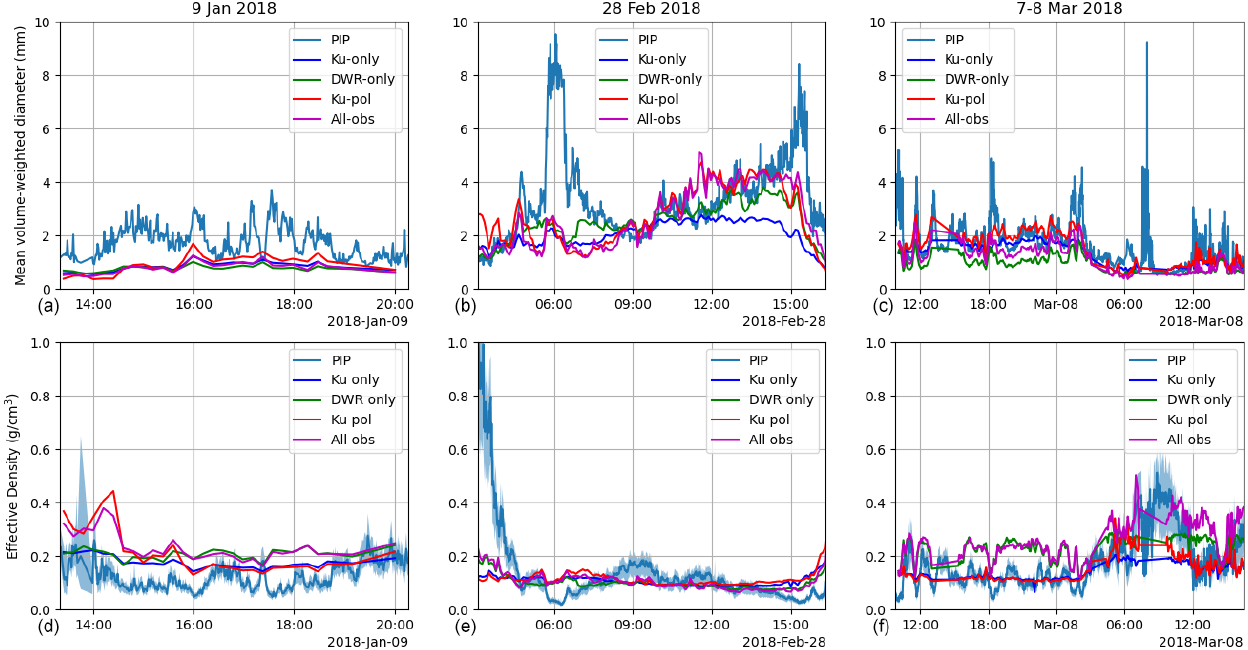
Figure 12. Time series of D3R- and PIP-derived mean volume-weighted particle diameter (a, b, c) and effective density (d, e, f) for each event. Because the PIP calculations involve a variety of assumptions to derive particle density from shape and fall speed (Tokay et al., 2022), a range between the minimum and maximum from these calculations is shaded around the mean PIP-derived